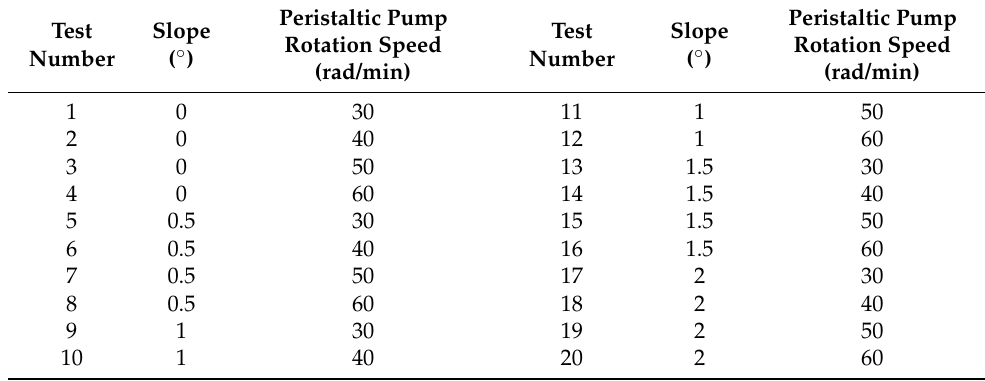
Table 2. Specification of the testing configurations.